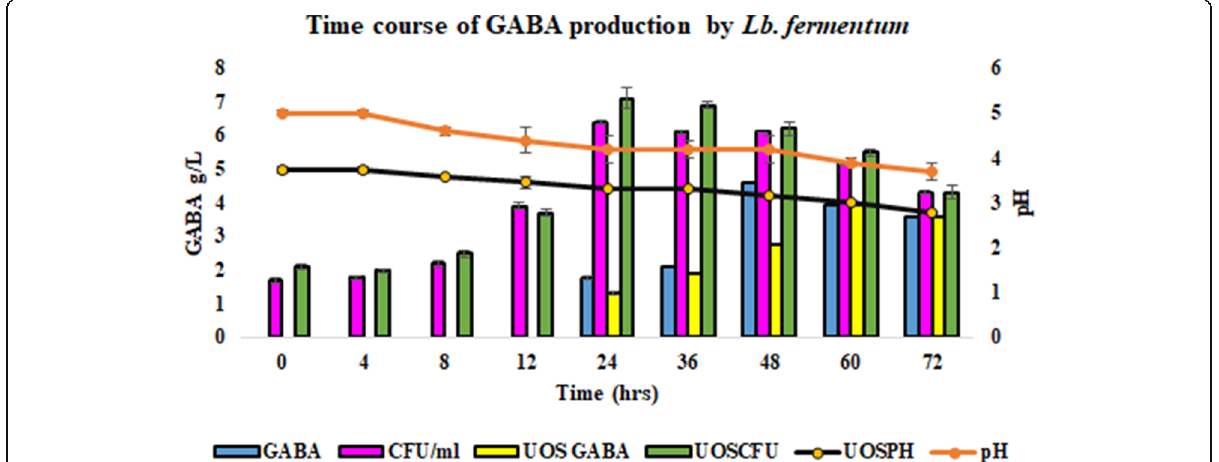
Fig. 3 GABA production, bacterial growth, and pH values during time course of soymilk fermentation with Lb. fermentum under optimized conditions. Blue, pink, and red bars indicate GABA, bacterial growth, and pH values from soymilk with optimized conditions. Yellow, green, and black bars indicate GABA, bacterial growth, and pH values from soymilk with unoptimized